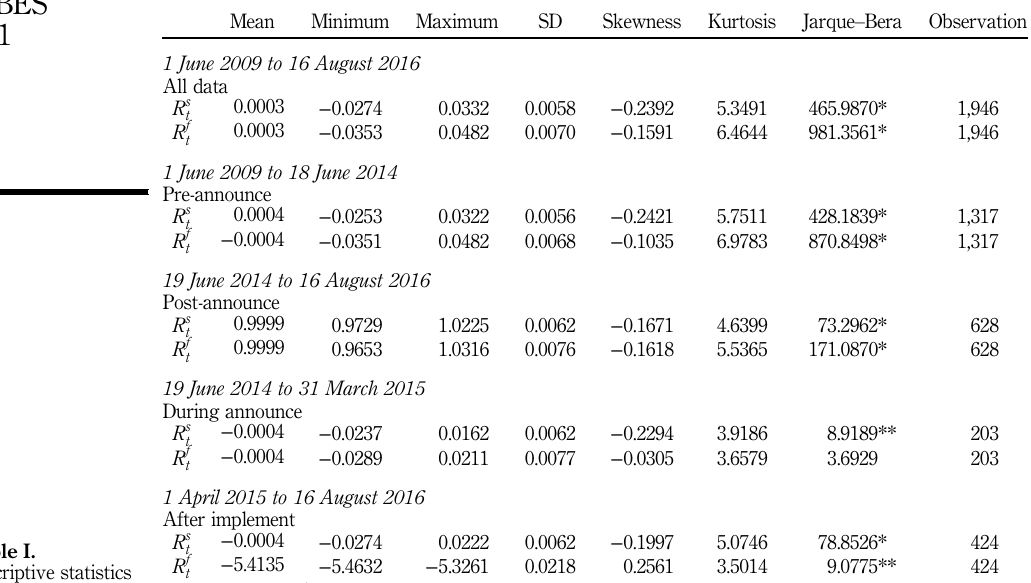
of returns series of RKLCI ( R s and RFKLI ( R f